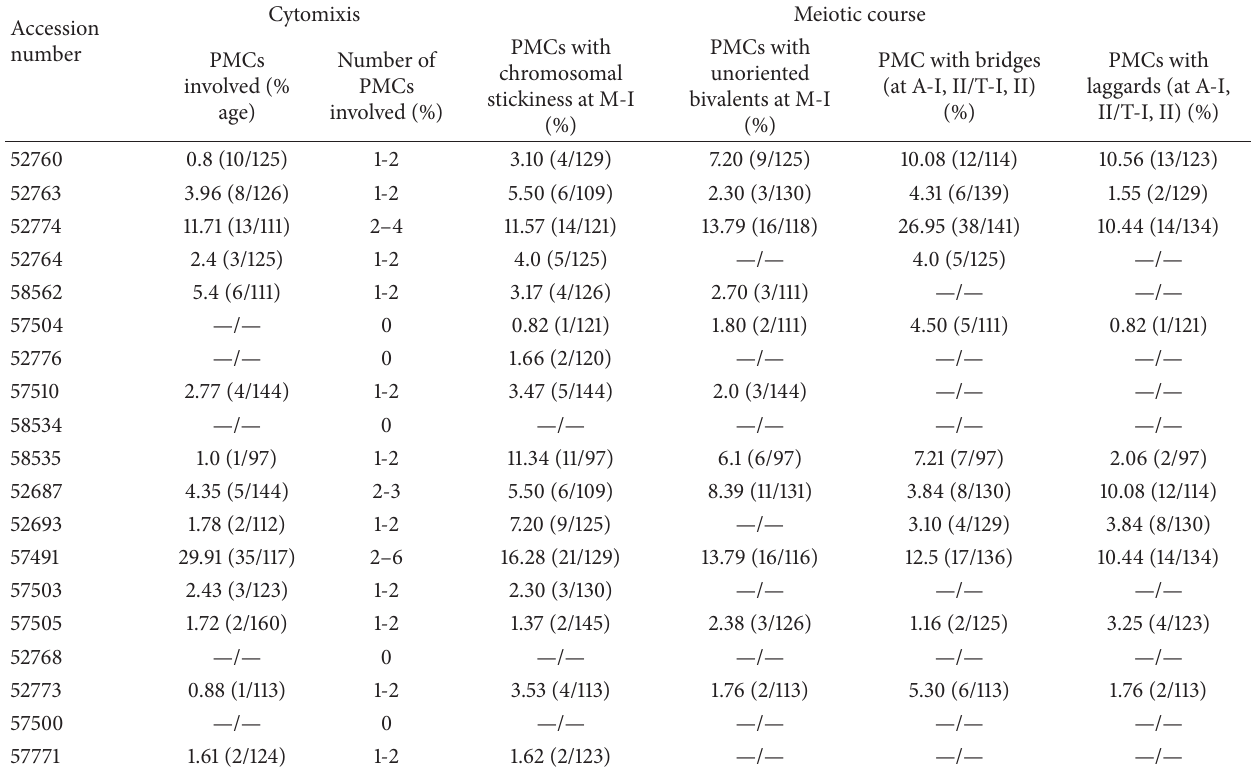
Table 3: Data on cytomixis and meiotic course in the studied populations of tribe Cichorieae from Western Himalayas. Accession